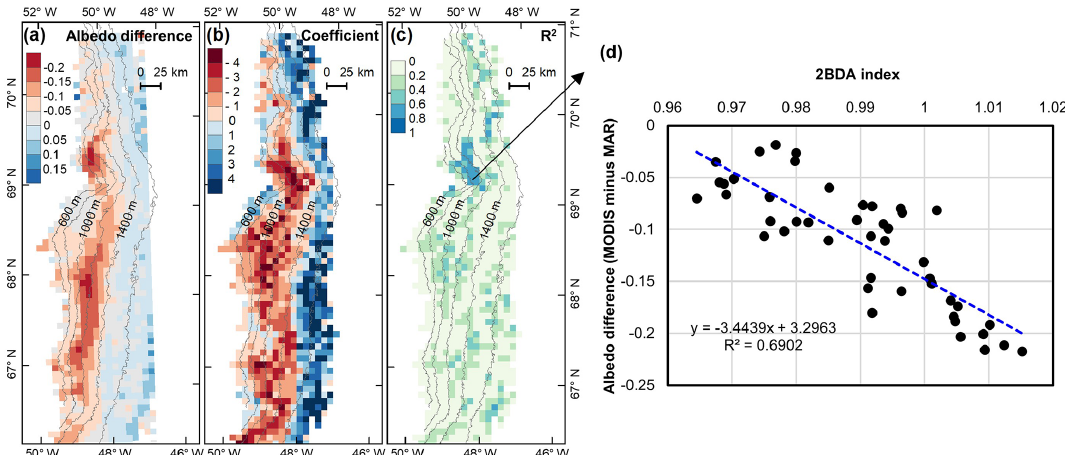
Figure 12. (a) Albedo difference between MODIS albedo and MAR albedo (MODIS albedo minus MAR albedo) averaged over the study period. (b) Regression coefficients of albedo difference with 2BDA index. (c) R 2 estimates for the regression analysis. (d) Scatterplot of albedo difference vs. 2BDA index over the DS algae-abundant area and the equation for the linear